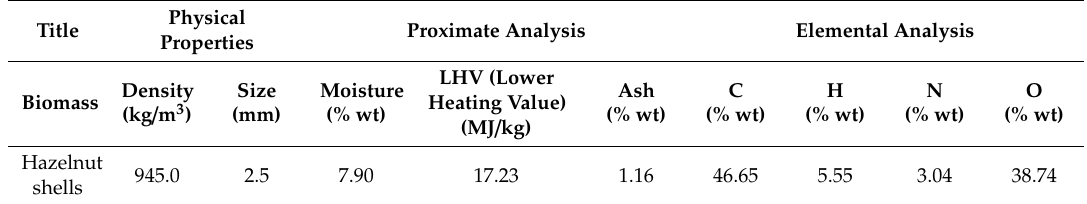
Table 2. Physical and chemical properties of hazelnut